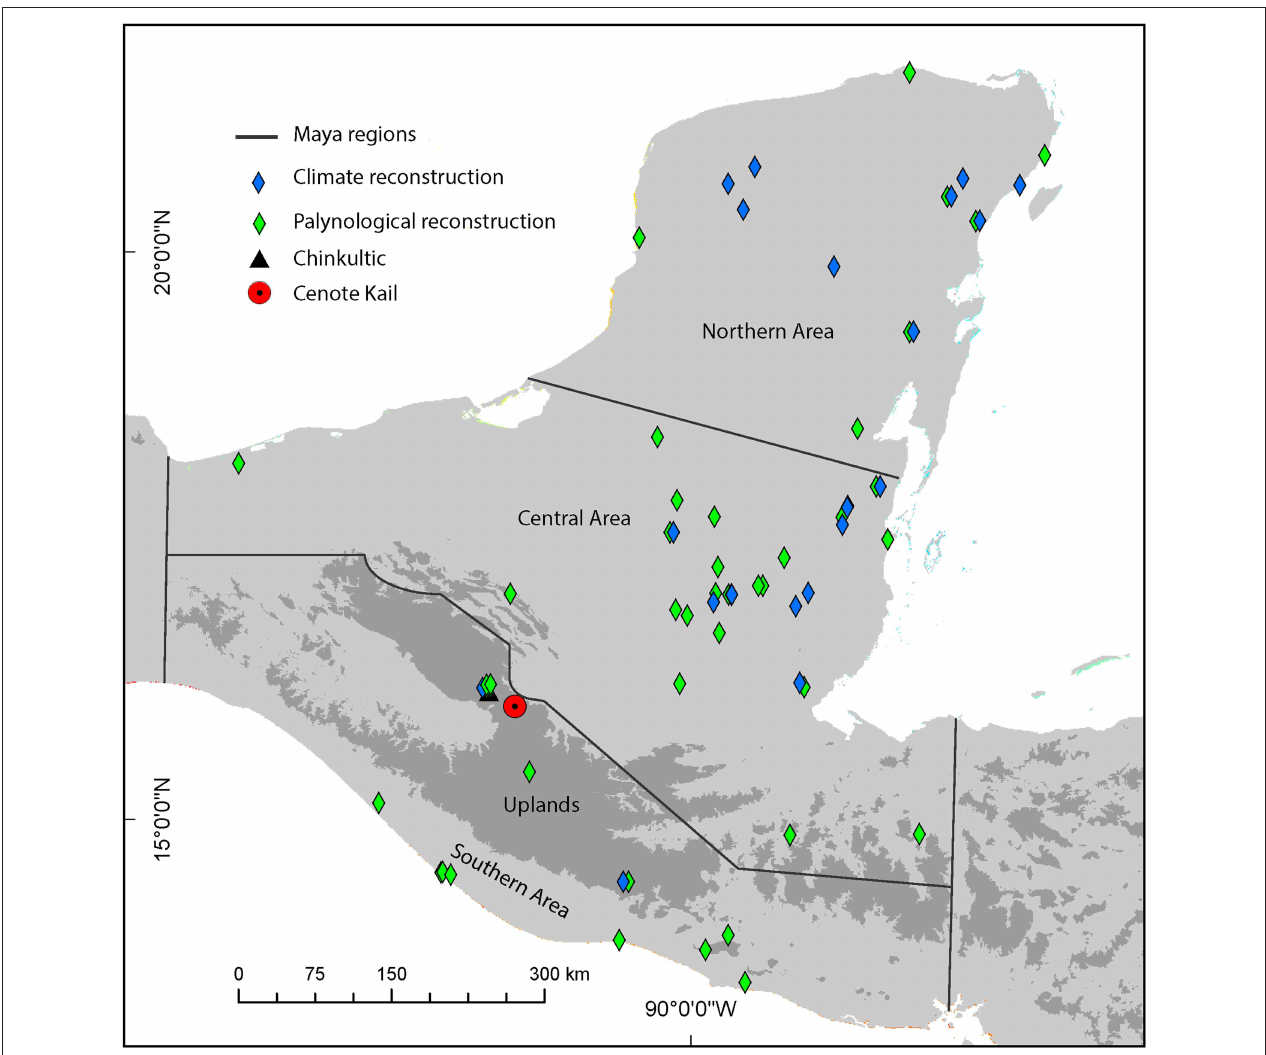
FIGURE 1 | Topographic map of Central America depicting (i) Maya regions; (ii) independent climate proxies (blue diamonds); (iii) previous vegetation reconstructions in the Maya Area (green diamonds); (iv) location of archaeological complex Chinkultic (black triangle); and (v) location of Cenote Kail (red circle). Dark gray shading represents elevation > 1,000m.a.s.l. (see Supplementary Information for